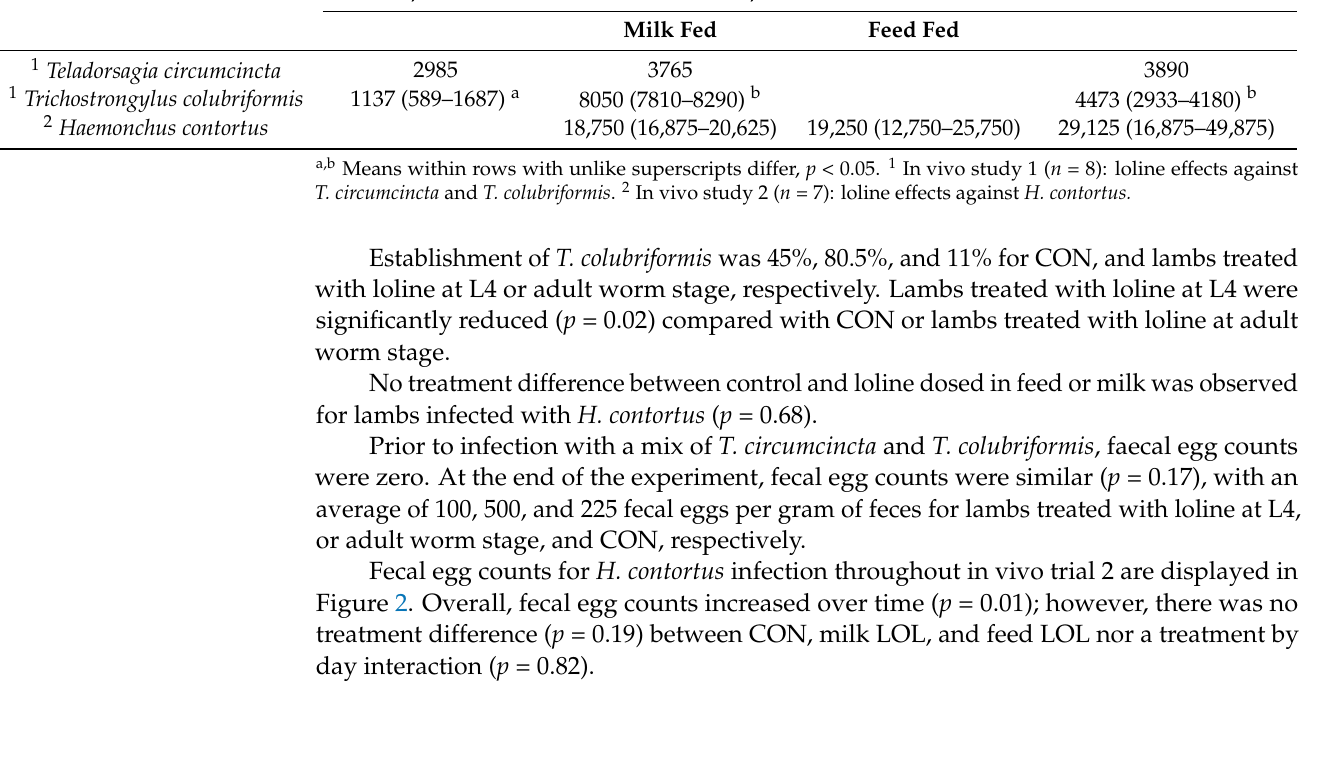
Table 4. Average worm count of Trichostrongylus colubriformis , Teladorsagia circumcincta , or Haemonchus contortus of CON lambs or lambs treated with loline at L4, or adult worm stage, through feed or milk. Average Worm Count LOL, L4 Dose LOL, Adult Dose